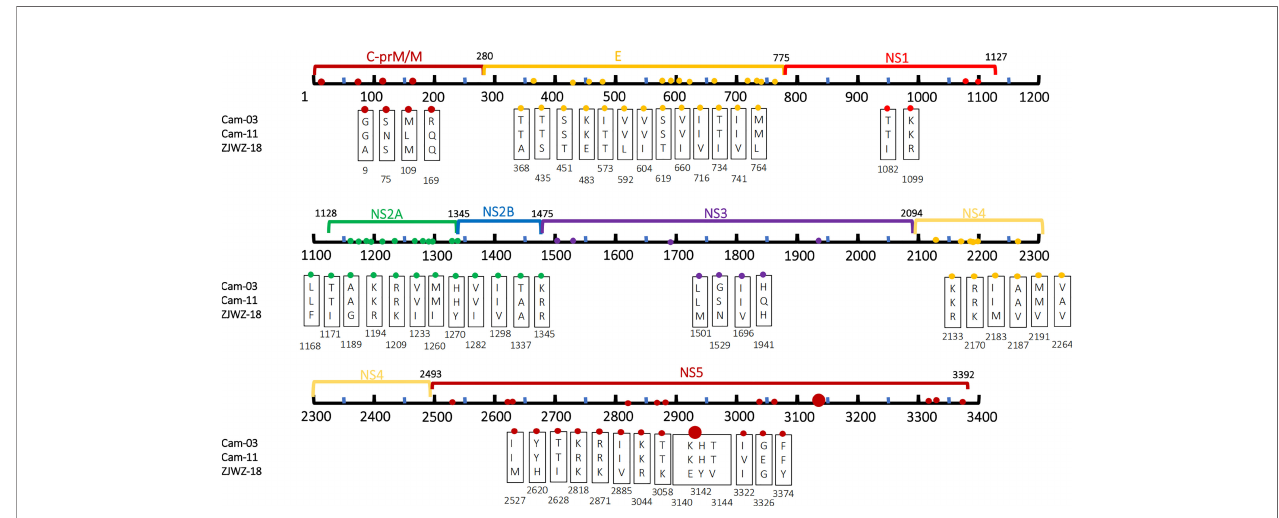
FIGURE 4 | Amino acid mutations between CDS of Wenzhou local strain and 2 strains with traveling Cambodia. The labeled numbers represent the amino acid position.